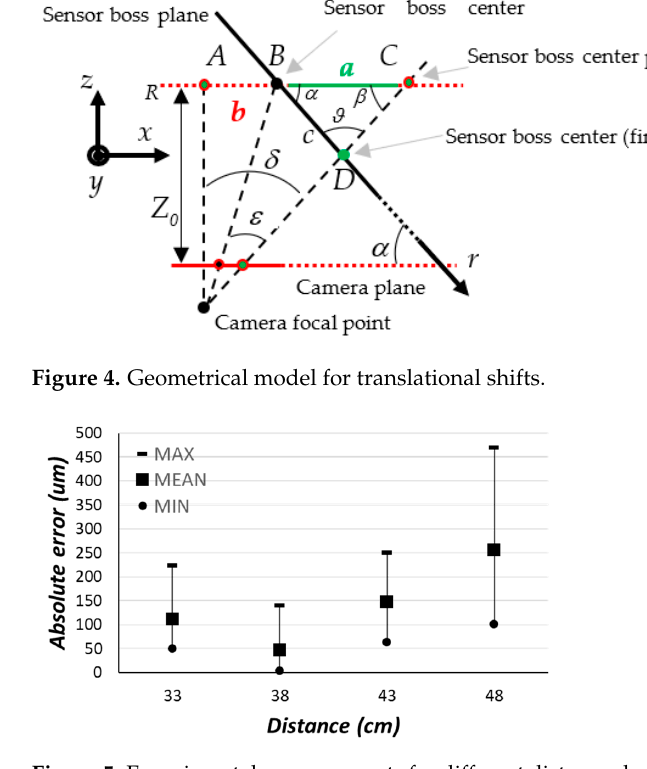
Figure 6. Obtained measurements applying the proposed model as a function of the translational shift extent and the angle between the camera and the sensor boss planes ( 𝑏 = 5 cm and 𝑍 (cid:2868) = 48 cm). Finally, the model was able to detect possible rotations of the sensor boss boundary. Such displacements can occur along an axis passing through the sensor boss center. The geometrical model was enhanced, as depicted in Figure 7, where 𝜙 is the rotation angle to detect, 𝑍 (cid:2868) is the distance between the camera and the sensor boss planes for 𝜙 = 0, and B (D) is the point representing the left border of the sensor boss boundary for 𝜙 = 0 ( 𝜙 > 0). According to the camera pinhole model, points D and C are projected onto the image plane in the same position. Due to the rotation, the sensor boss on the image plane assumes an elliptic shape with an eccentricity depending on 𝜙 , so the length of the segment 𝑐 can be obtained by finding one semi-axis of such an ellipse. Towards this aim, a synthetic ellipse is drawn in the image tracing the sensor boss boundary, as depicted in Figure 8, and the lengths of the semi-axes (in pixels) are obtained. The latter is then converted into a measure in the real world by Equation (2). Afterward, the rotation angle 𝜙 can be calculated by Equation (5), derived by the geometrical model of Figure 7: 𝛽 = 𝑎𝑟𝑐𝑡𝑔 |(cid:3029)(cid:2878)(cid:3028)| (cid:3027) (cid:3116)